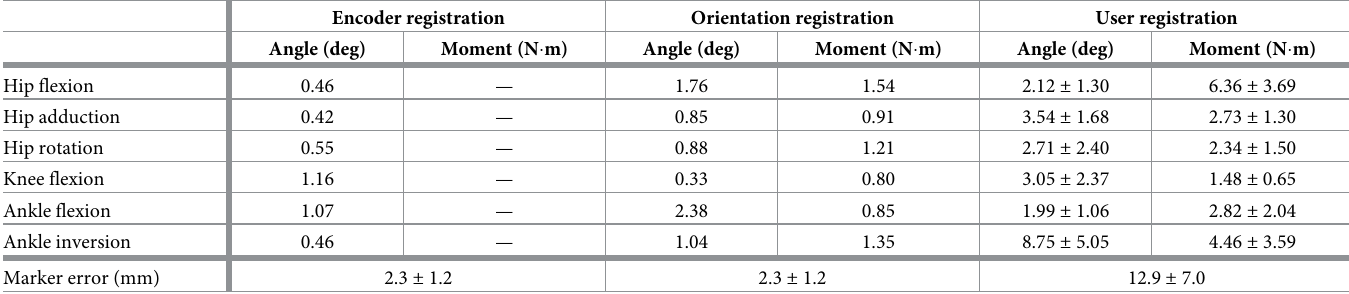
Table 1. Joint angle and joint moment errors for each marker registration method examined in this study. Joint angle accuracy (“Angle”) is computed as the RMSE between inverse kinematics calculations and robot encoder data; joint moment accuracy (“Moment”) is computed for the orientation- and user-registered models as the RMSE between inverse dynamics calculations and the estimated moments from the encoder-registered model. Mean and standard deviations across the five OpenSim users are shown for the user-registered models. Mean and standard deviation of marker RMSE are computed for each registration method over all time